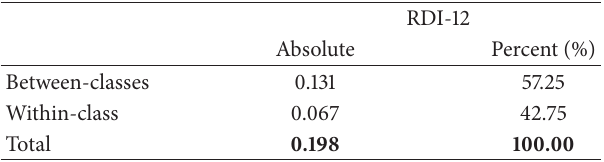
Table 4: Variance decomposition for the optimal